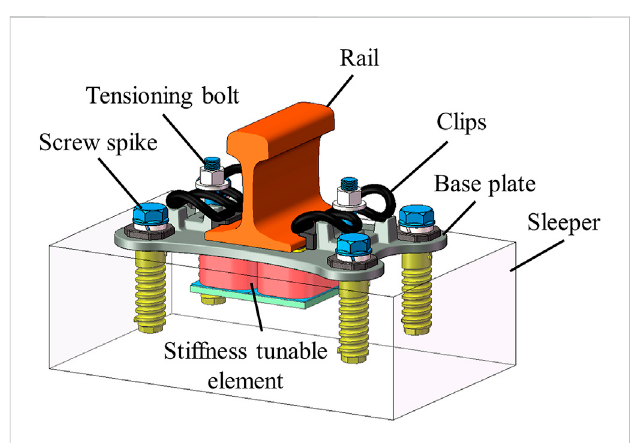
FIGURE 5 Design and structure of railway fastening system with MRE railway pad and magnetic controlling